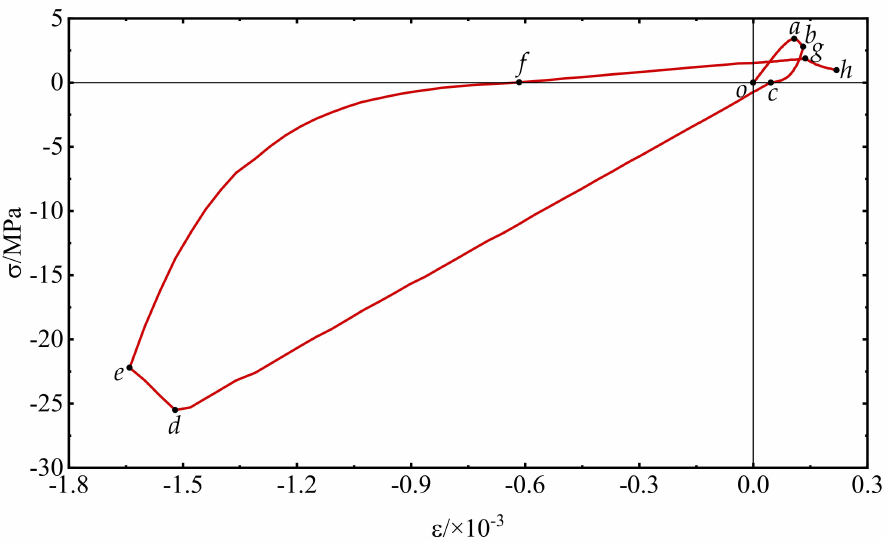
Figure 15. Stress − strain relationship under uniaxial reciprocating loading: the letters o , a , b , c , d , e , f , g , h are points on the curve of the uniaxial reciprocating loading.